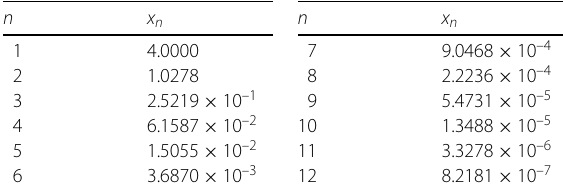
Table 2 The values of x n